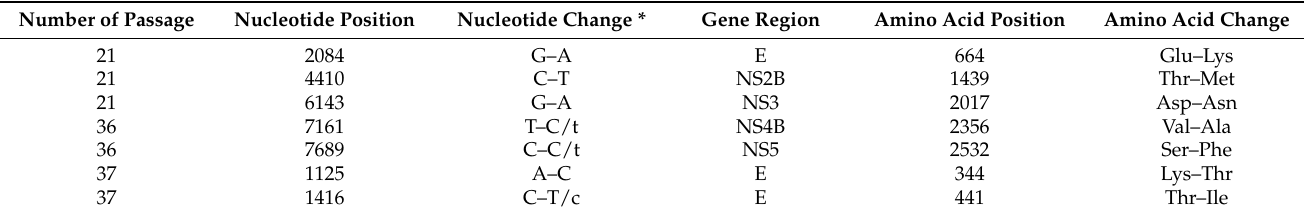
Table 2. Amino acid substitutions identified in the recovered viruses after serial